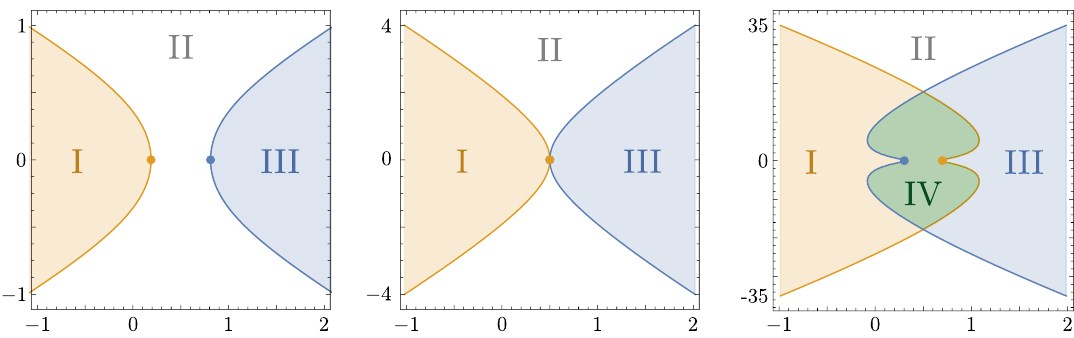
( w | ∆ )] = φ ∆ b = 1 . 8 (left), b